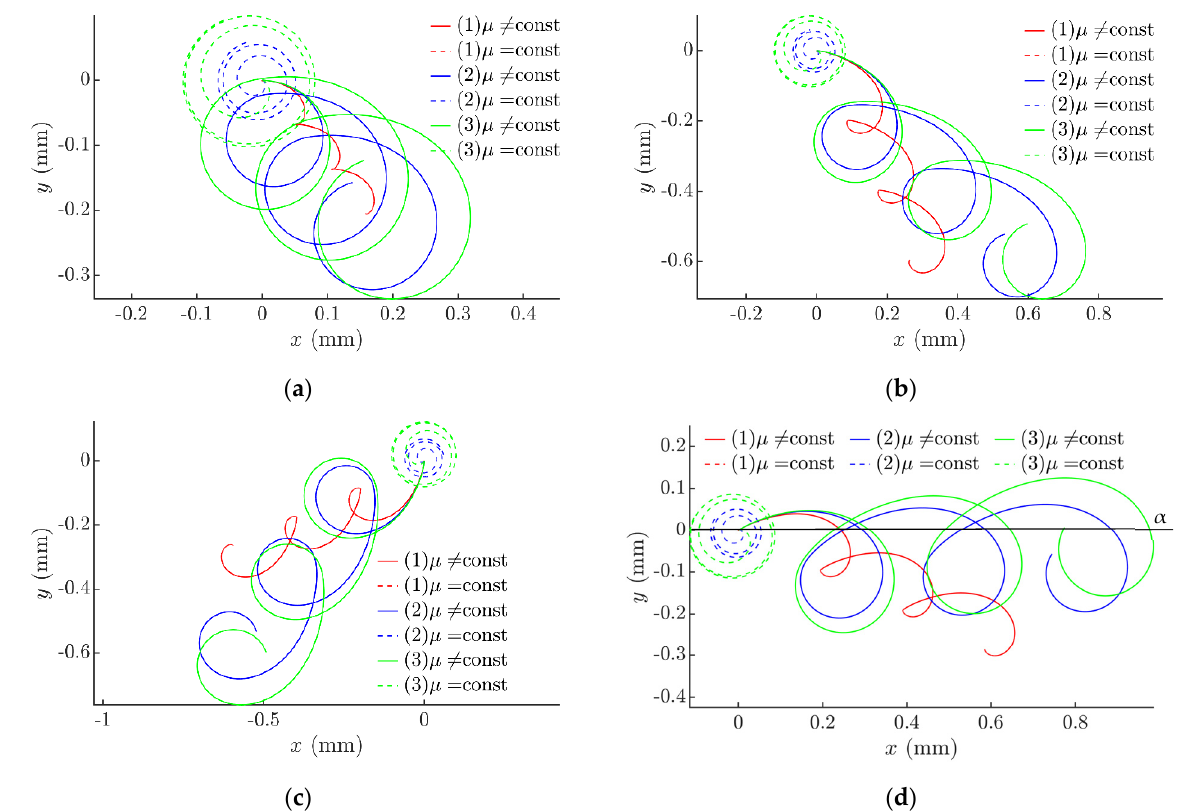
Figure 4. Trajectories of the part when μ 1 = 0.122, μ 2 = μ 1 /8, g = 9.81 m/s 2 , ω = 62.8 rad/s, ε = π /2; (1) A e = 0.28 mm, (2) A e = 0.31 mm, and (3) A e = 0.32 mm; ( a ) ϕ = 0, Δ τ = π /10; ( b ) ϕ = 0, Δ τ = π /4; ( c ) ϕ = 11 π /9, Δ τ = π /4; and ( d ) ϕ = 17 π /9, Δ τ = π /4.